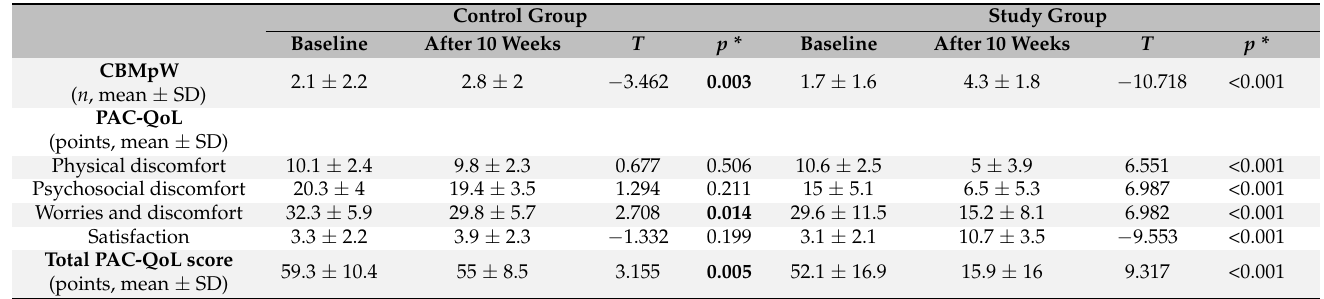
Table 2. Effect of treatments on stool frequency and quality of life at baseline and